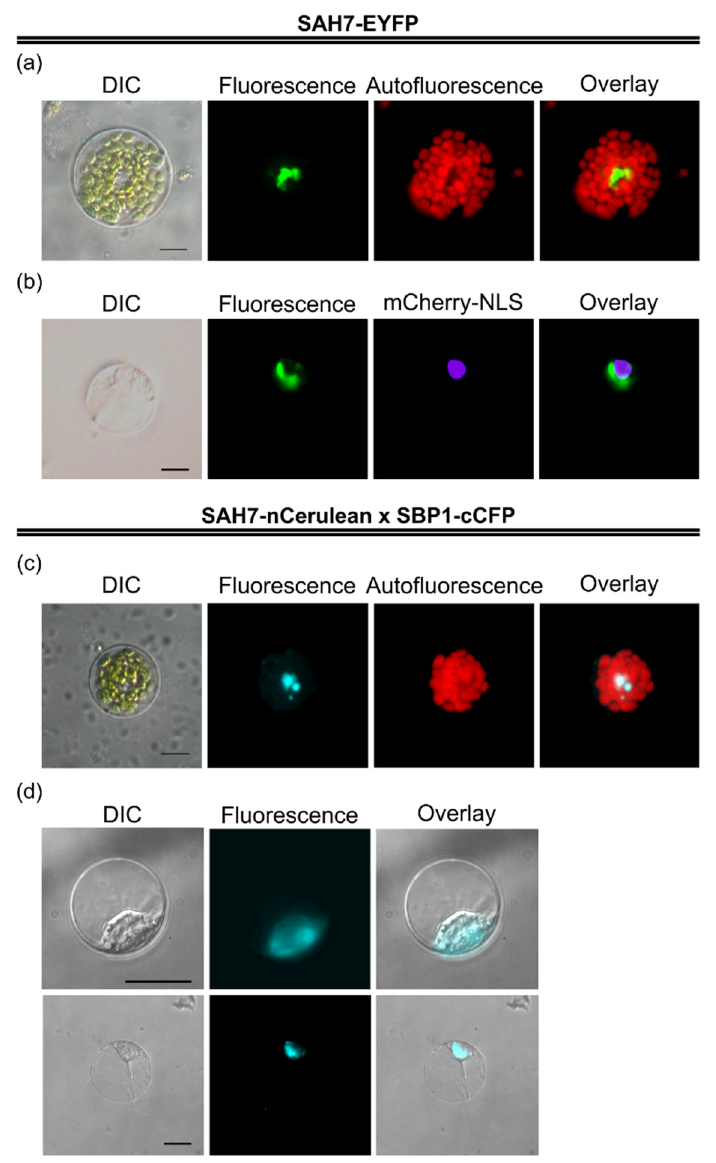
Figure 6. Transient expression of At SAH7 and BiFC assays in Arabidopsis mesophyll and root protoplasts. At SAH7 was fused to EYFP to study its subcellular localization in mesophyll protoplasts ( a ) and root protoplasts ( b ). Root protoplasts were isolated from stable 35S:mCherry-NLS 10d seedlings. Chimeric constructs of At SAH7-nCerulean and At SBP1-cCFP generated in order to determine the subcellular localization of the interaction in mesophyll protoplasts ( c ) and root protoplasts ( d ). Fiji (ImageJ) was used in order to pseudocolor mCherry-NLS to magenta ( b ) and BiFC to Cyan ( c , d ). At SAH7 is localized in a structure around the nucleus, probably ER. At SAH7 interacts in planta with all At SBP1 in similar structure to the one that At SAH7 localizes in. Bars 10 μ m.